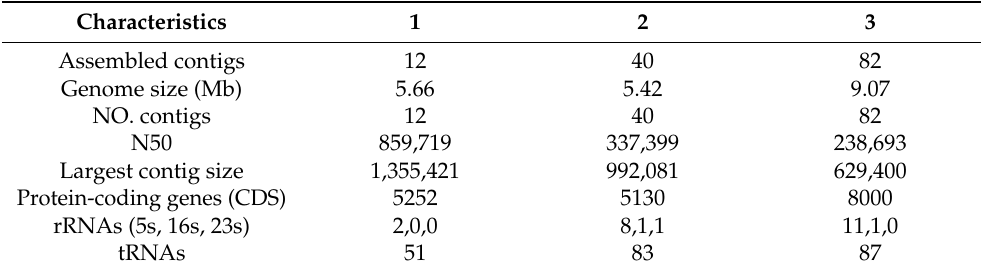
Table 4. General genome characteristics of (1) Paenibacillus endoradicis T3-5-0-4, (2)